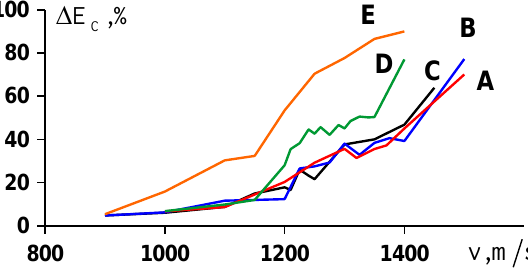
Fig. 5. Energy dissipation coefficient versus the impact velocity for different cluster initial temperatures: A - 0 K, B - 176 K, C – 345 K, D – 688 K, E – 1008